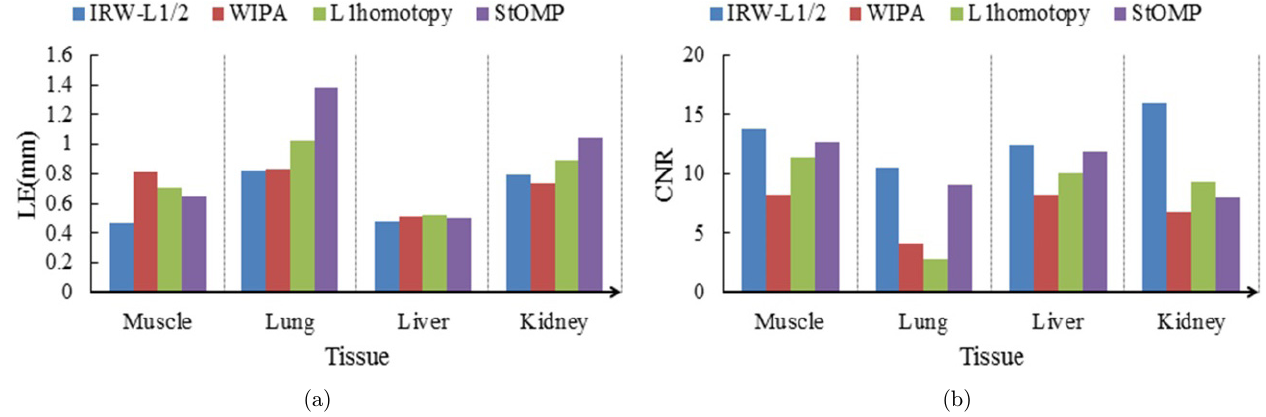
Fig. 5. Comparison results in reconstruction of single-target located in di®erent tissues (a) Location error. (b)